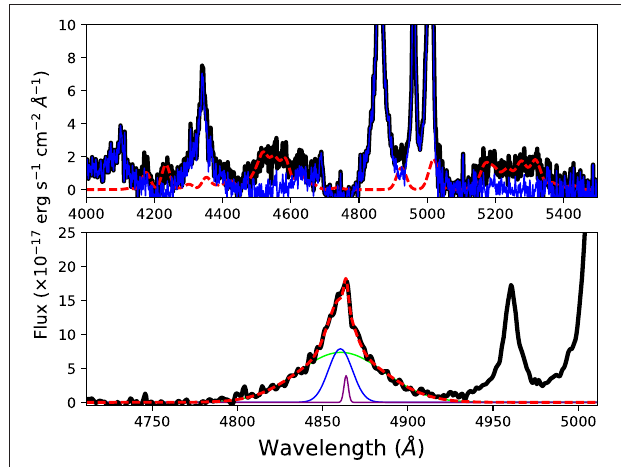
FIGURE 2 | Section of the optical spectrum of 3C 286, obtained from the SDSS-BOSS survey. Top panel: black solid line is the region between 4,000 and 5,500 Å restframe continuum subtracted, the red dashed line represents the Fe II template, while the blue solid line is the spectrum after the iron subtraction. Bottom panel: black solid line indicates the H β region, the three Gaussians used to reproduce the line profile are indicated by the green, blue and purple solid line, and the red dashed line represents their